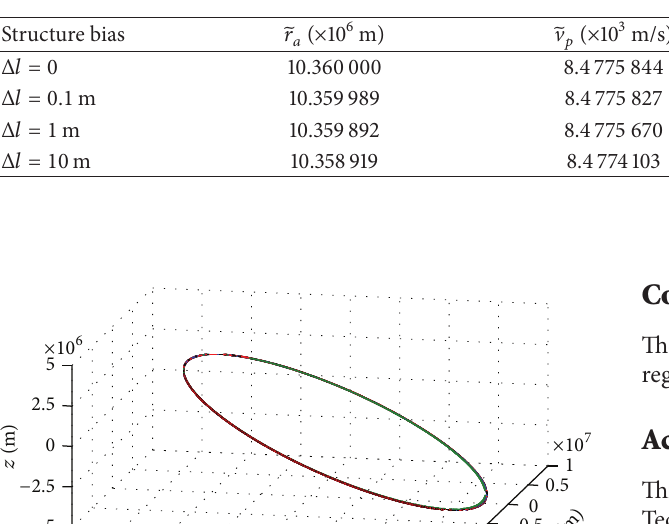
Table 4: The relative orbital errors with difference in tethers’ length.